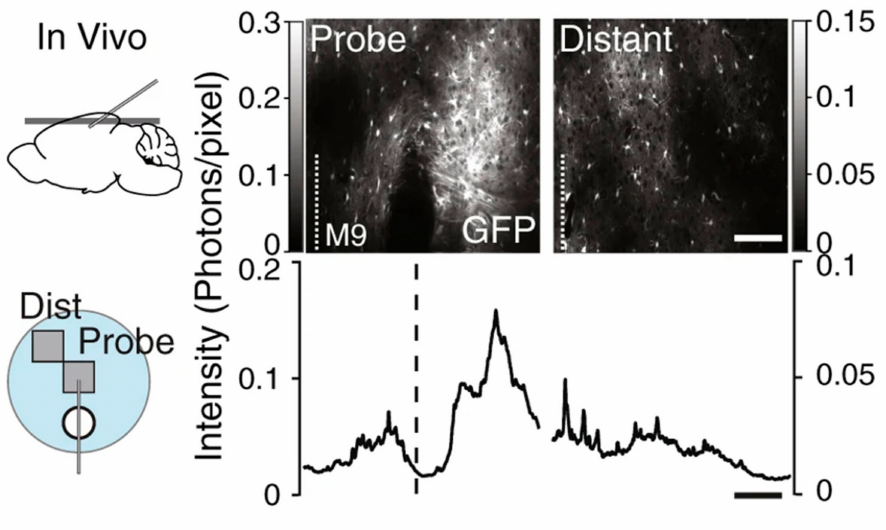
Figure 12. Astrocytes expressing GFP local to probe implantation (probe) and the adjacent area (distant) in vivo mice model. An increased density of astrocytes is associated with glial scarring. Reprinted with permission